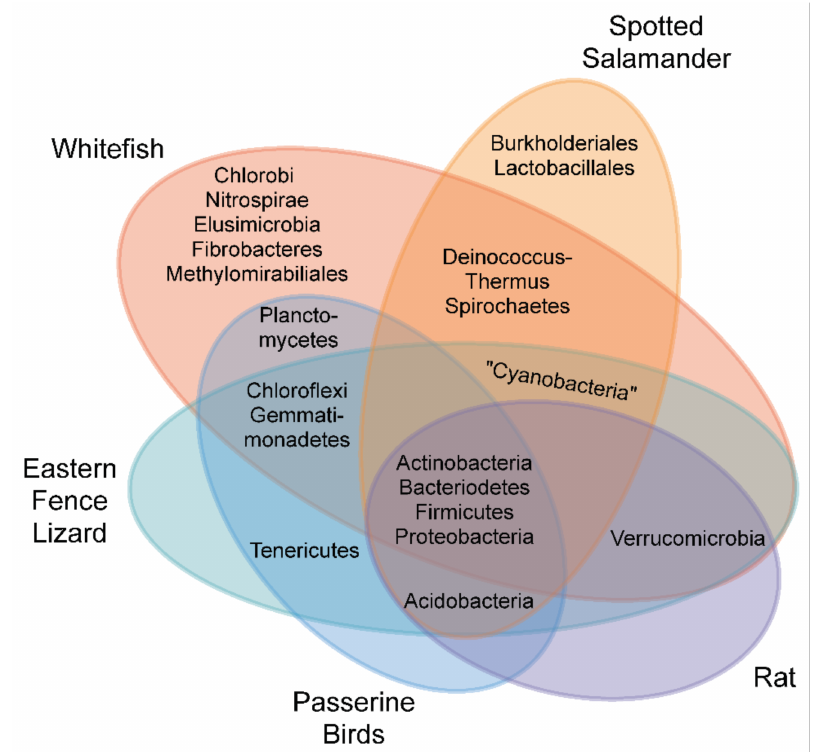
Figure 2. Venn diagram of bacterial phyla identified inside in ovo and in utero microenvironments of representative vertebrates through 16s rDNA metabarcoding [32–35]. Whitefish ( Corregonus spp.) perivitelline fluid sampling was followed by amplification of the V1–V2 16s regions and taxonomy classification with RDP2.2 and Greengenes 12.10 [32]. Spotted salamander ( Ambystoma maculatum ) egg capsule fluid sampling was followed by V4–V5 amplification and classification with SILVA132 [33]. Rat ( Rattus norvegicus domestica ) amniotic fluid extraction was followed by V3–V4 amplification and Greengenes 13.8 classification [34]. Eastern fence lizard ( Sceloporus undulatus ) and four passerine ( Poecile atricapillus , Sialia sialis , Passer domesticus , and Tachycineta bicolor ) in ovo contents were extracted followed by V4 amplification and Greengenes 13.8 classification [35]. Other studies have described teleost fish, bird and rodent embryonic microenvironments to be sterile [36–38]. “Cyanobacteria” may represent free living prokaryotes or chloroplast DNA. Identification of conserved embryo-associated phyla is preliminary as methodologies, including exclusion of negative control sequences, were inconsistent between studies. Bacterial communities from the rat study were verified through FISH staining in fetal gut [34] and the salamander study cultured multiple bacterial isolates from the same capsular fluid